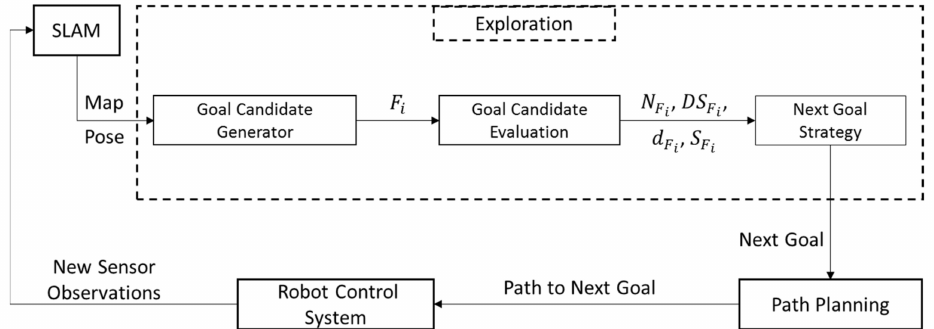
Figure 1. The architecture of the proposed exploration system, starting with SLAM to provide the occupancy map and the robot pose. The exploration module detects all frontiers ( F i ) to be evaluated based on the number of features ( N F ), distribution score ( DS F ), distance to the robot ( d F ), and size i i i of the frontier ( S F ). Accordingly, the next goal strategy selects the highest score candidate as the i best new goal. The next goal is sent to the path planner to generate the path from the current robot position. Finally, the robot control system applies the received path to reach the next goal and gain new sensor observations. This exploration iteration is repeated until finishing all accessible